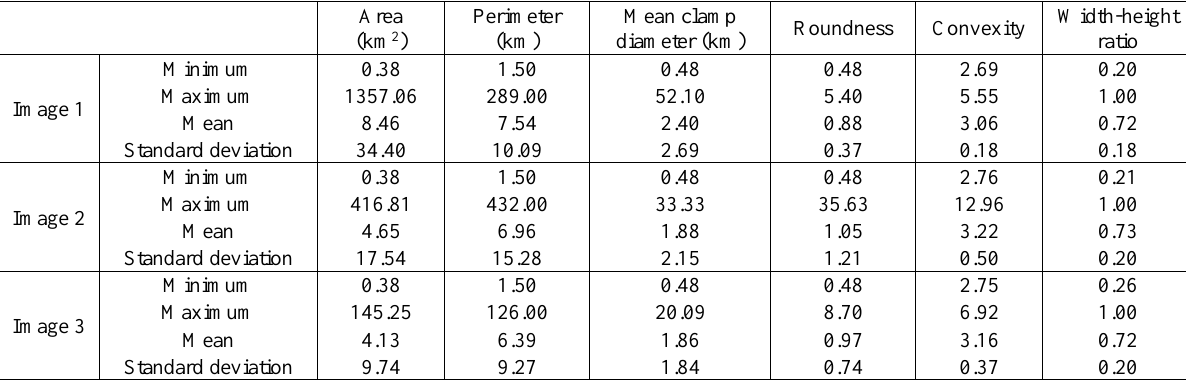
Table 2 The distribution parameters estimated from the three images recorded on June 10, July 14 and August 18, 2014. The minimum, maximum, mean and standard deviation of shape parameters were estimated